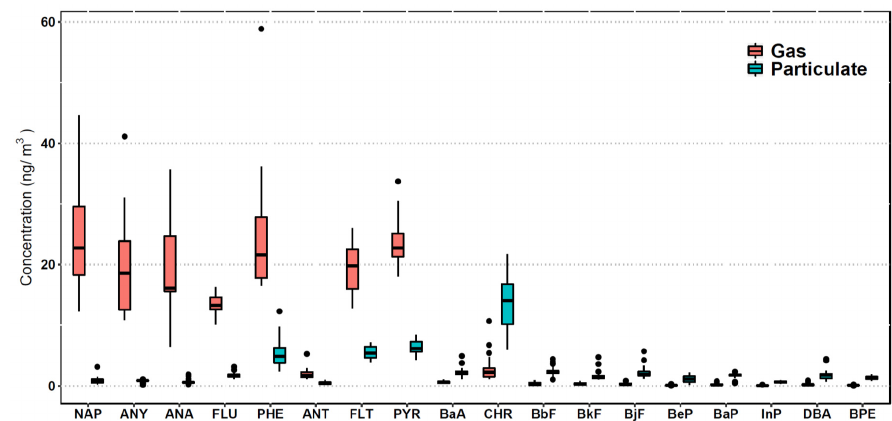
Figure 3. Concentrations of PAHs in the particulate and gas phases.